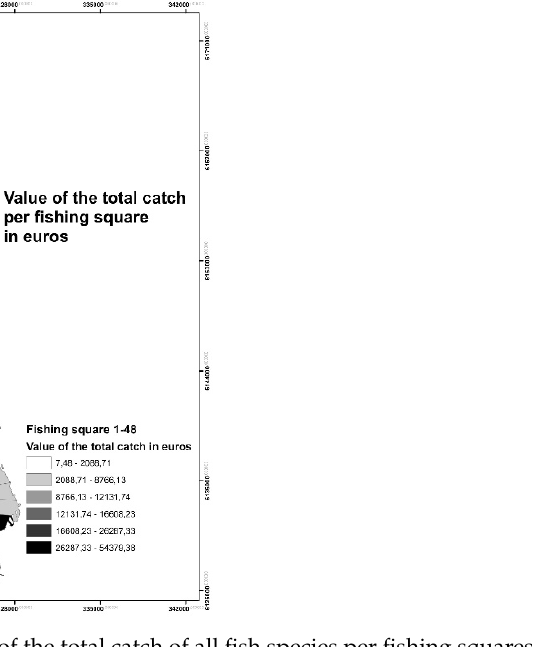
Figure 7. Evaluated value of the total catch of all fish species per fishing squares by using monthly fisheries reports with the stated initial sale price of each fish species.